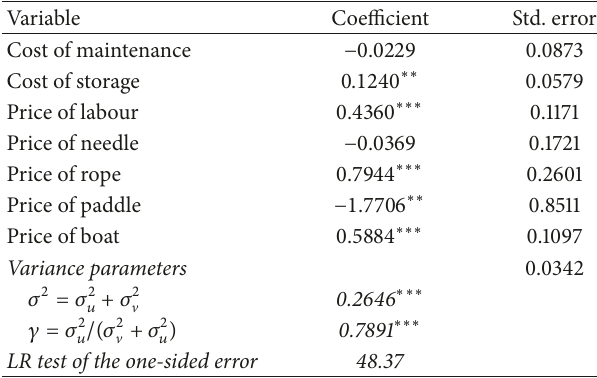
Table 2: Estimated coefficients of the stochastic profit frontier model for